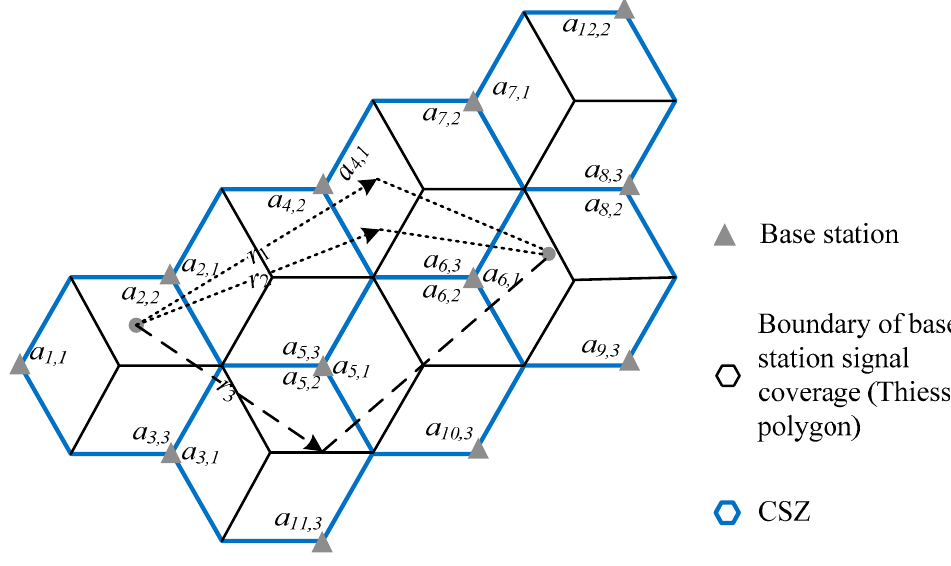
Figure 2. The relationship between the road route and the base station antenna ID path.